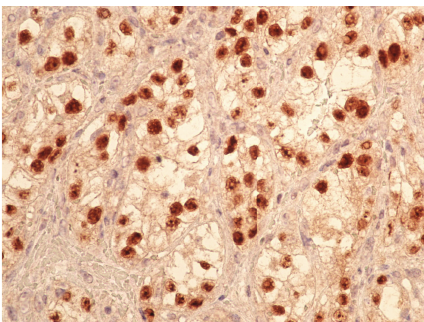
Figure 3: Duodenal mucosa with metastatic alveolar clusters of clear cell renal carcinoma. Tumor cells strongly immunoreactive to PAX8 intranuclear immunostain.